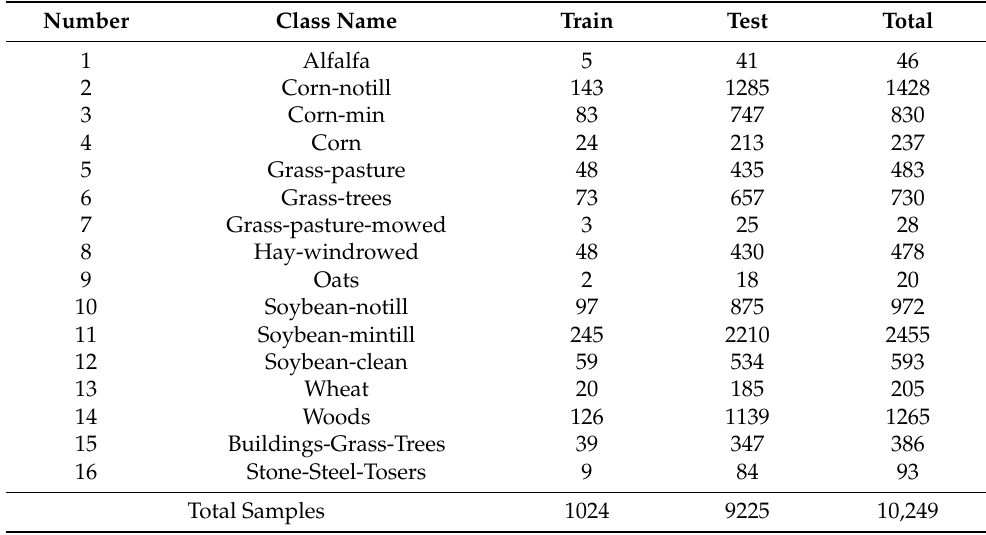
Table 1. Number of training and testing samples for the India Pines dataset.